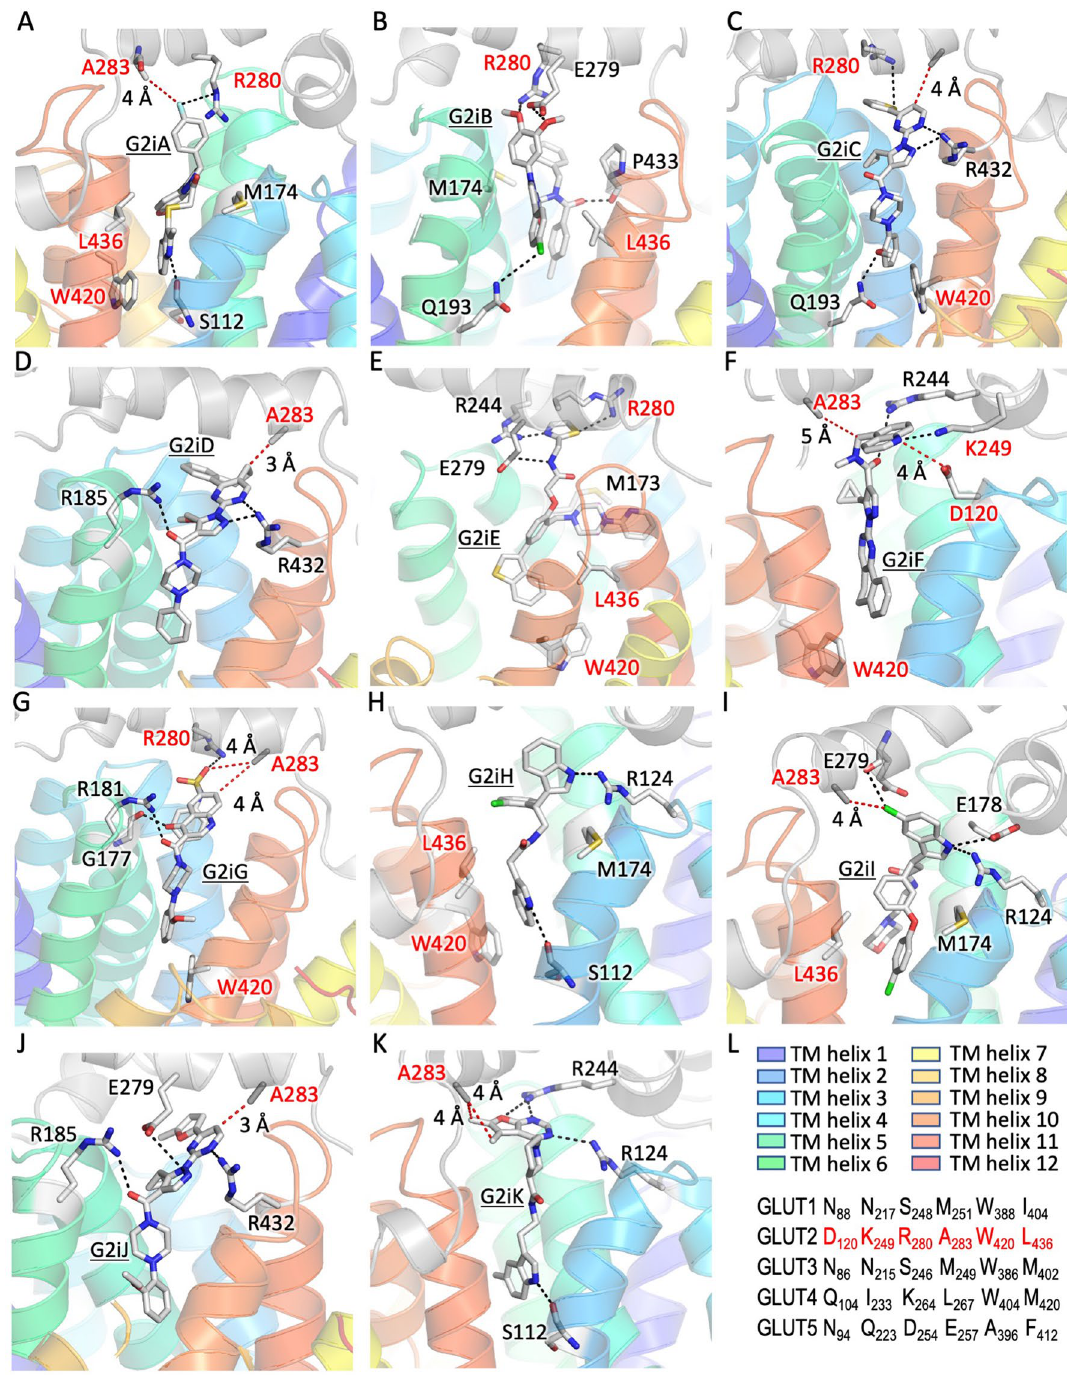
Figure 4. Docking sites of G2iA-G2iK in the inward-facing conformation GLUT2 model. G2iA-G2iK dock in the superior region of the substrate cavity, distinct from the glucose binding site (see Fig. 1B). Close-up views for the docked ligands: G2iA ( A ), G2iB ( B ), G2iC ( C ), G2iD ( D ), G2iE ( E ), G2iF ( F ), G2iG ( G ), G2iH ( H ), G2iI ( I ), G2iJ ( J ), and G2iK ( K ). Residues that are not conserved in GLUT1-5 are in red. ( L ) GLUT1-5 sequence alignment for unconserved protein residues interacting with G2iA-G2iK in the GLUT2 model. The color-code identification of transmembrane (TM) helices is the same as in Fig.